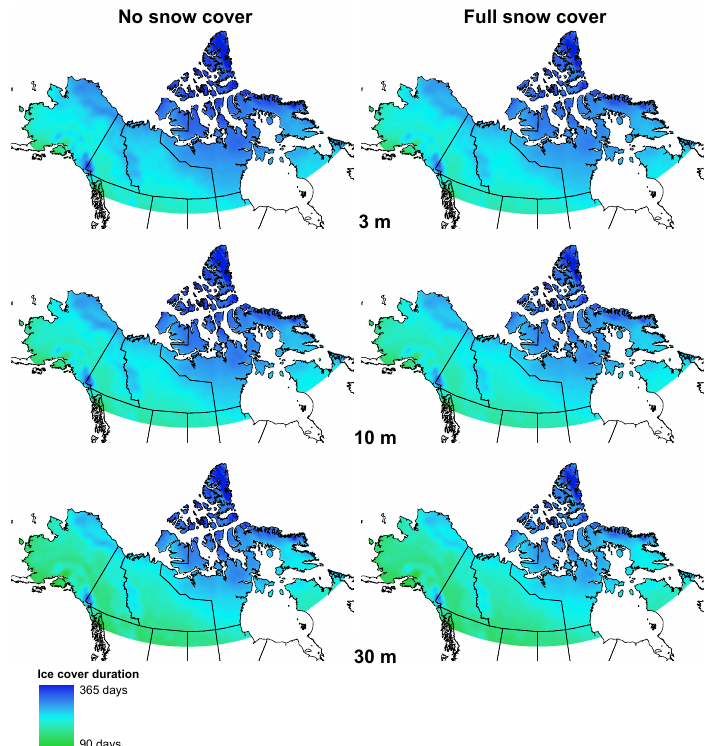
Fig. 6. Mean ice cover duration for 1961–1990 for the three depth simulations, for both the no snow and full snow